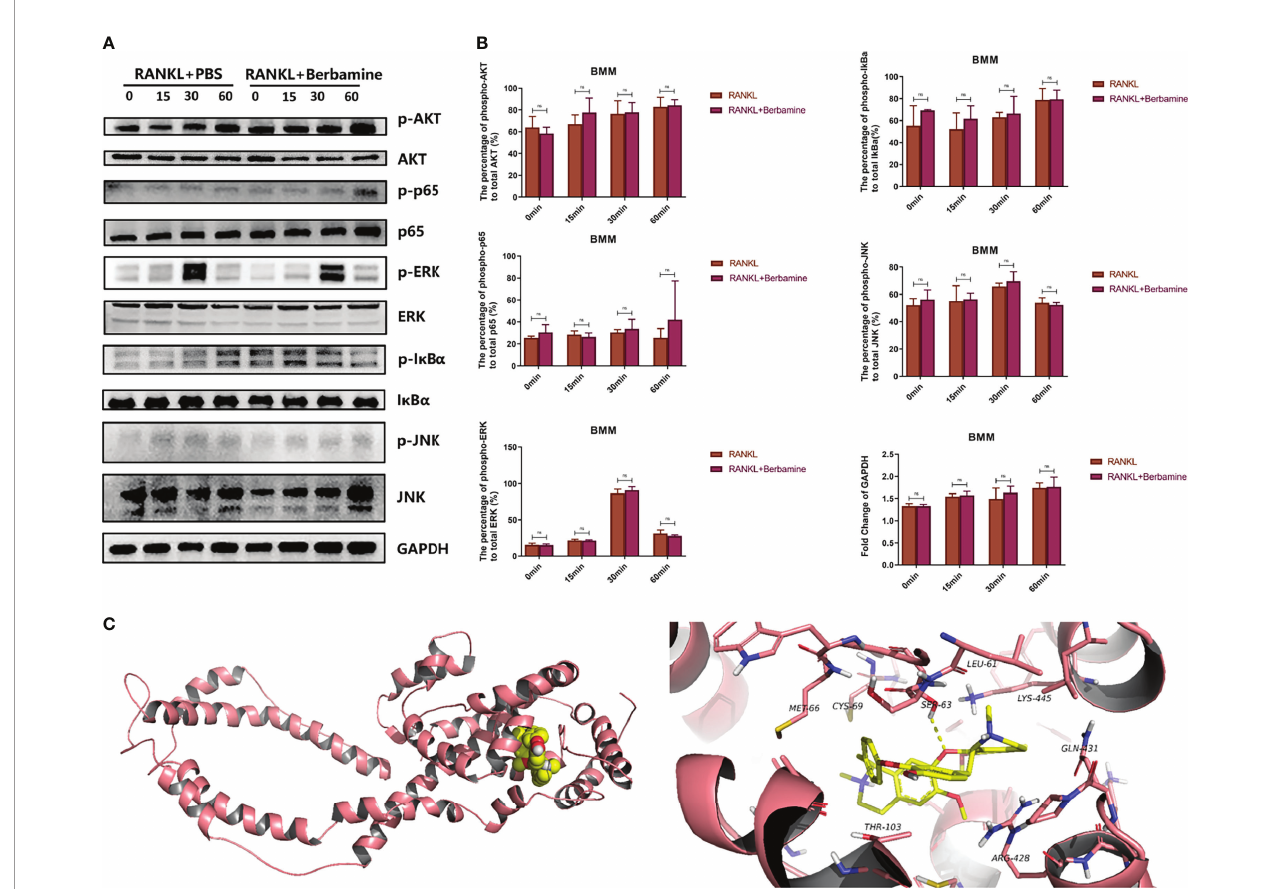
FIGURE 4 | (A) Berbamine cannot inhibit RANKL-induced activation of multiple common signaling pathways in the early phase of osteoclastogenesis, western blot images showing the phosphorylated and total protein levels of AKT, p65, ERK, I k B a and JNK induced by RANKL with or without berbamine. (B) Quanti fi cation of phosphorylated and total AKT, p65, ERK, I k B a , and JNK protein expression levels. The data are presented as the mean ± SD; ns, no signi fi cance. (C) Molecular docking of berbamine with DC-STAMP. The pink ribbons represent DC-STAMP, and the 3D structure that consists of yellow sticks represents berbamine. The yellow dashed lines represent H-bonds. The calculated free energy of the binding of berbamine with DC-STAMP is -5.808